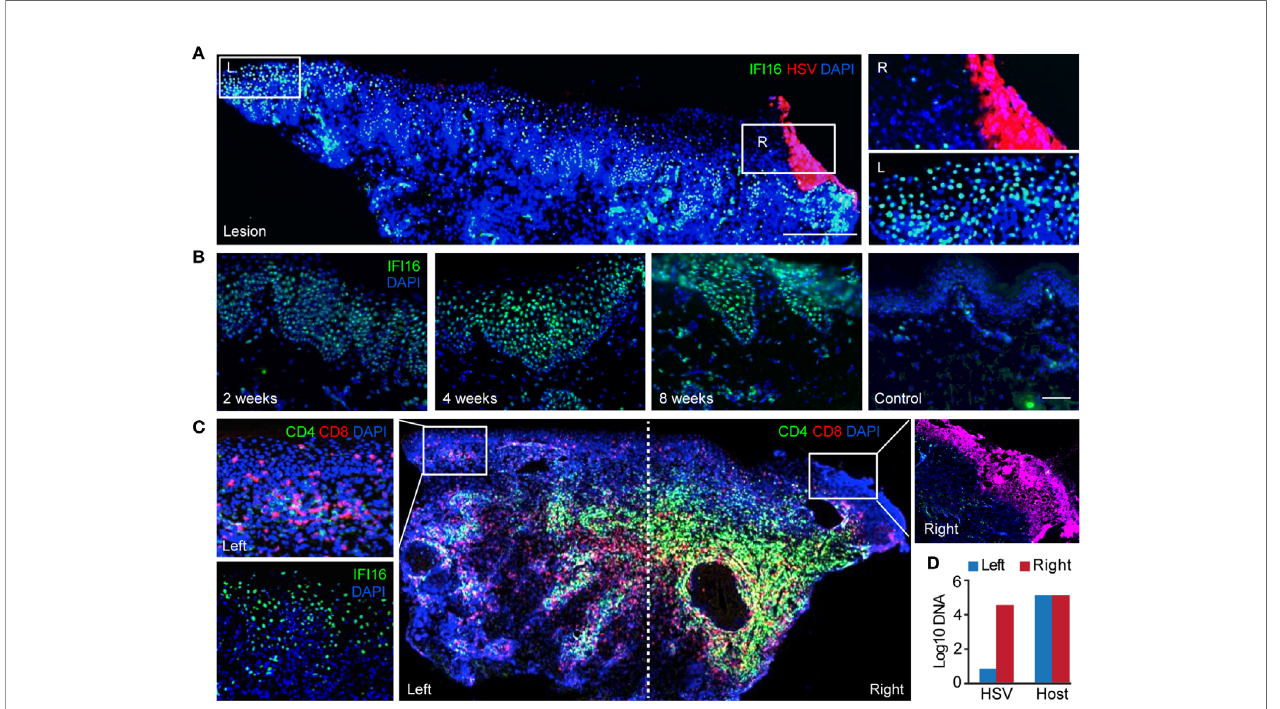
FIGURE 2 | Widespread expression of IFI16 in genital skin during and after HSV-2 recurrence. (A) IFI16 expression in a representative HSV-2 ulcer lesion. Right box depicting actively infected epidermis with HSV-2 antigen expression. Left box showing uninfected epidermis distal to HSV lesion. Scale bars, 500 µm. (B) IFI16 expression in a representative serial skin biopsies sequentially obtained at 2-, 4-, and 8-week post-healing and in matched arm control skin. Scale bars, 100 µm. (C) Distribution of CD4 + and CD8 + T cells and IFI16 expression in an ulcerative HSV-2 lesion. IFI16 and HSV-2 antigen expression staining were performed on adjacent tissue sections. Inserts are higher magni fi cation of the indicated boxed areas. (D) Quantitative PCR measurement of HSV-2 DNA and host genome in the right and left portion of the lesion tissue as designated in (C)